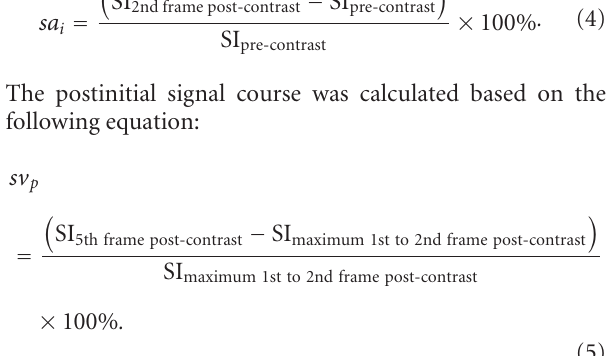
neural units changing their synapses with every